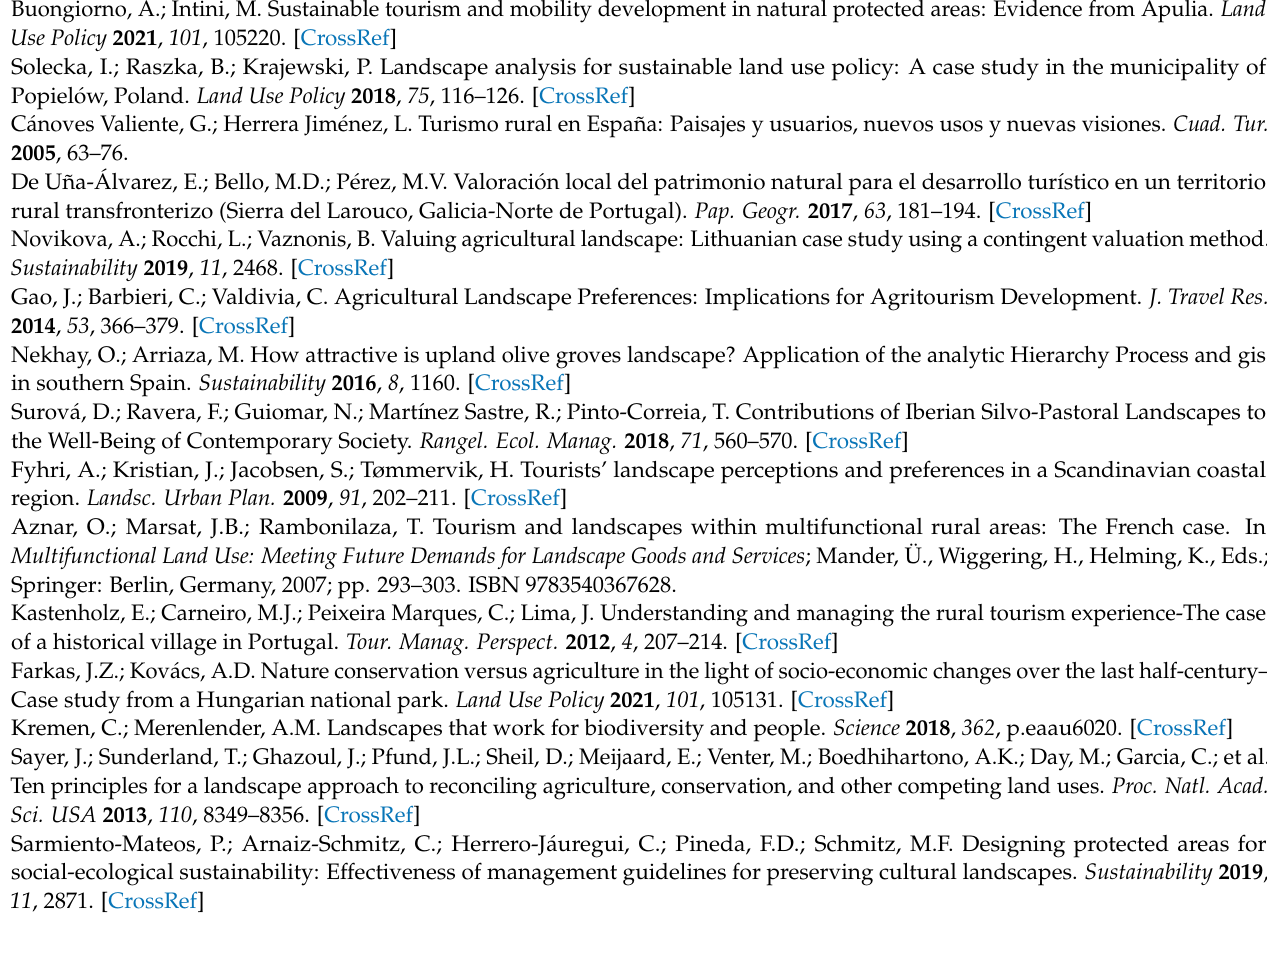
methodology; Figure S2. Ranking of landscape preferences evaluated without photo; Figure S3. Ranking of landscape that conveys positive